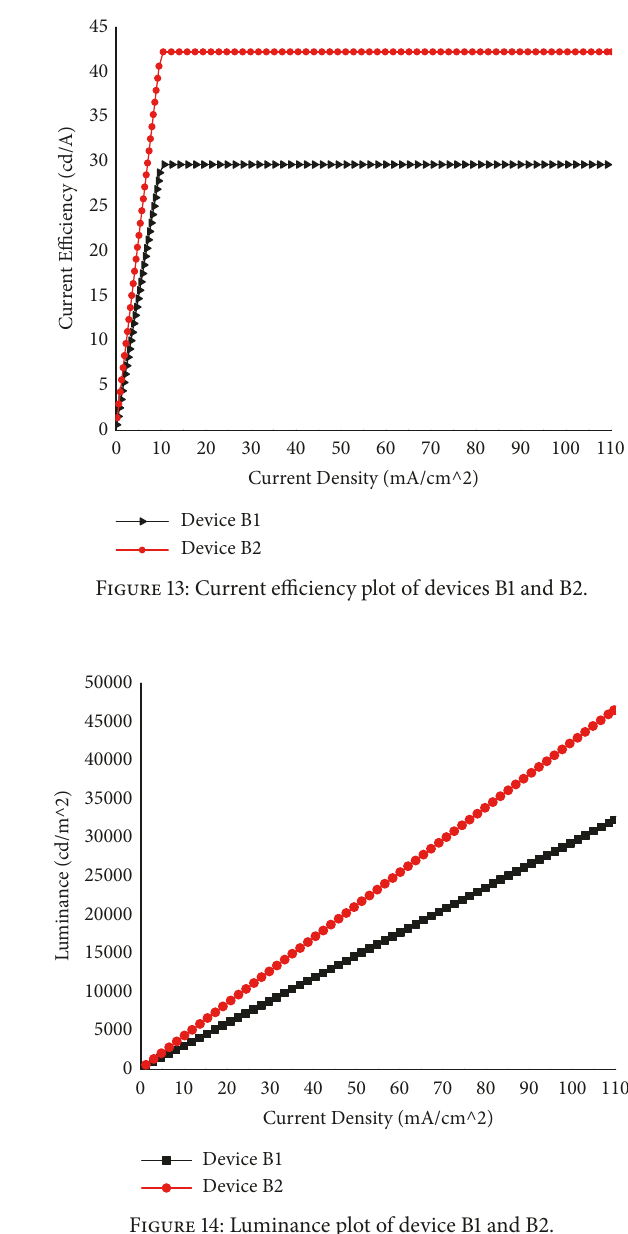
Figure 14: Luminance plot of device B1 and